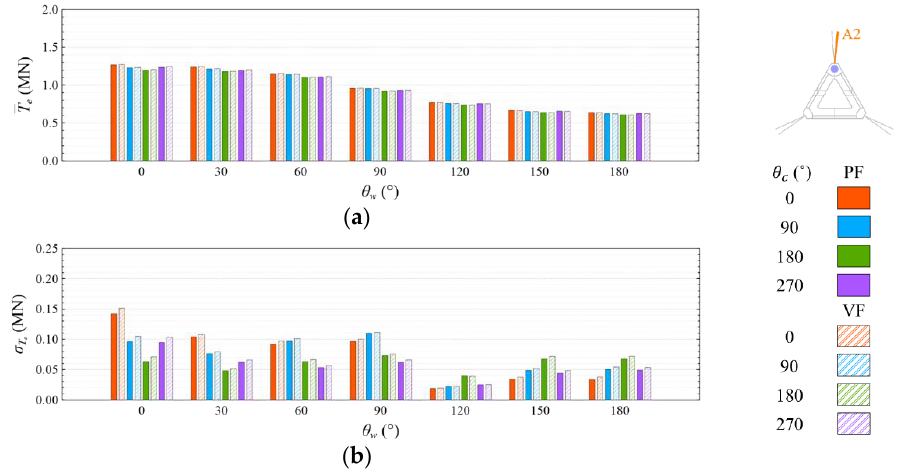
Figure 35. Comparison of ( a ) means and ( b ) standard deviations of mooring line tension of Line A2 under HW condition.